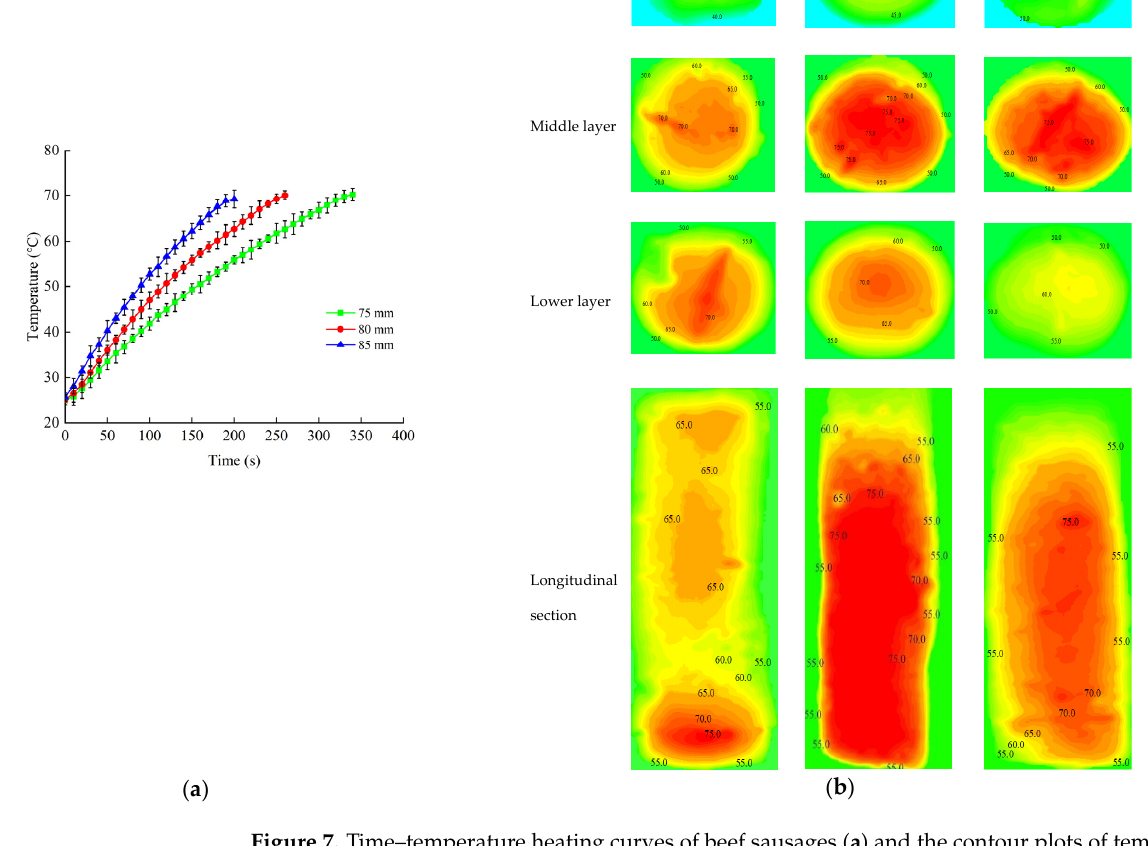
Figure 7. Time-temperature heating curves of beef sausages ( a ) and the contour plots of temperature distribution ( b ) at different sample heights (75, 80 and 85 mm) under an electrode gap of 180 mm and the temperature was initialized as 25 °C.